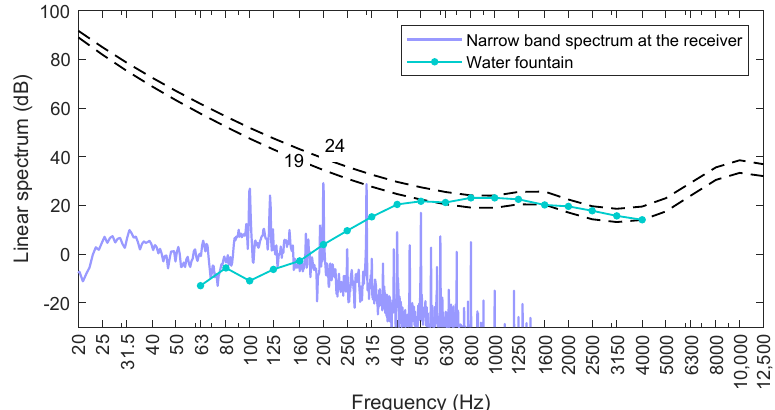
Figure 21. Masking the tonal component using a water fountain noise (shifted spectrum from [40]). Dashed lines: equal loudness contours at 19 phon and 24